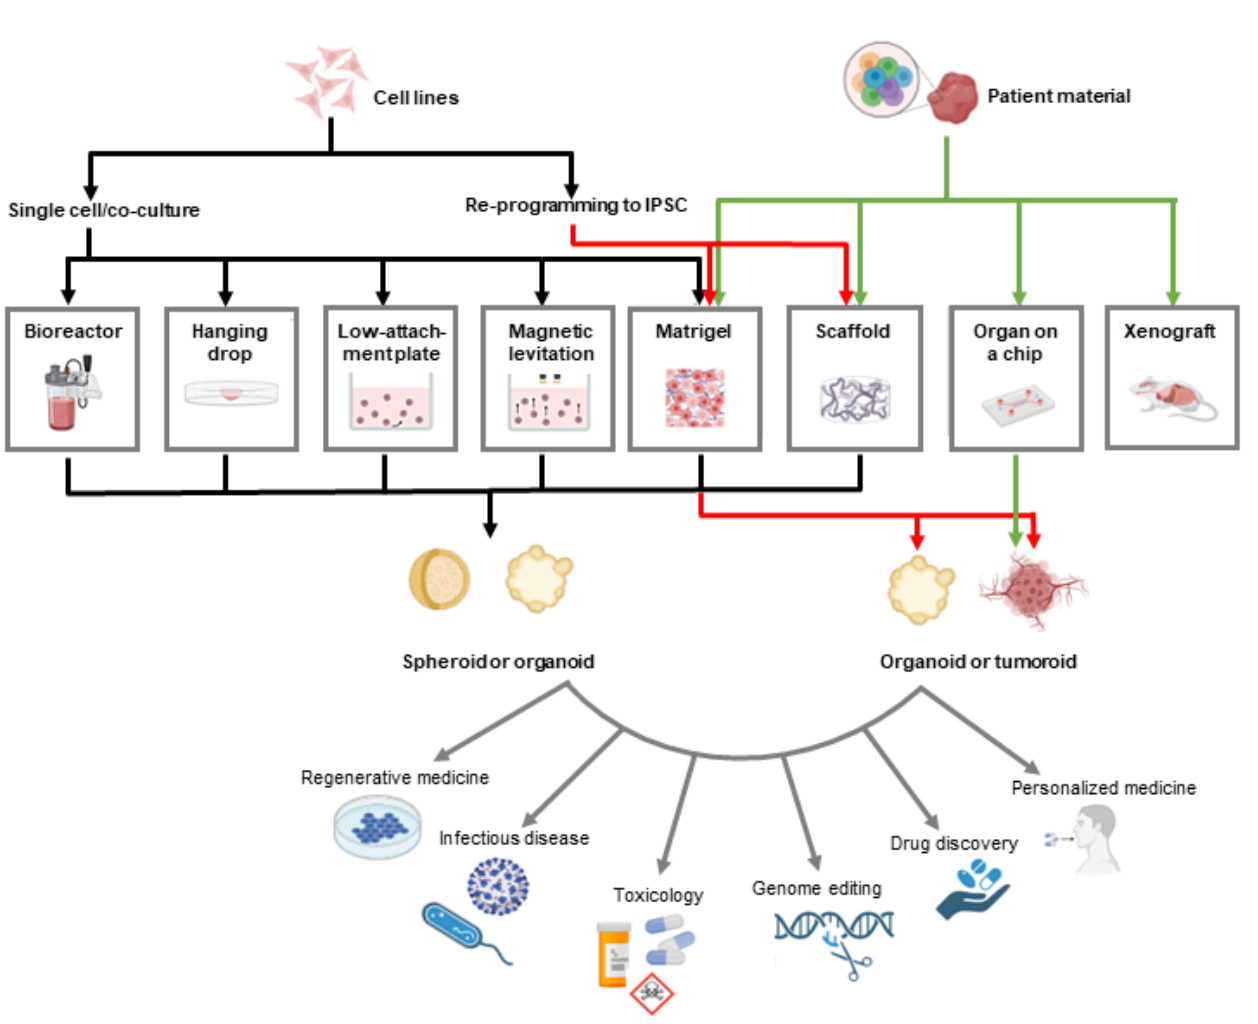
Figure 1. Outline of different methods for generating 3D models. If the starting material is cell lines, they can be grown as single cultures or co-cultures to generate spheroids or reprogrammed to IPSC and then differentiated in vitro using matrices and scaffolds to generate organoids. If patient material is used, it is usually dissociated into single cells before plating onto scaffolds, matrices, or chips to generate organoids or tumoroids. Patient material can also be implanted into animal models as xenografts. The prepared 3D cultures can then be used for a variety of applications, as presented in this schematic. Created in